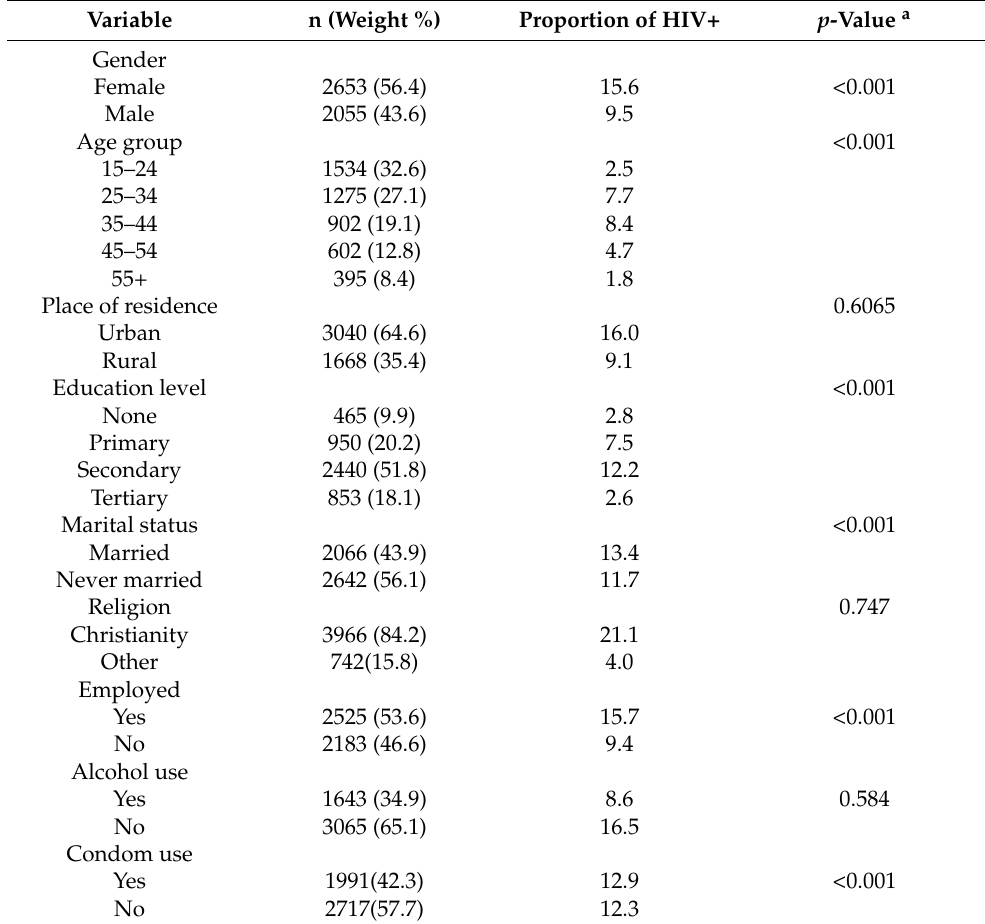
Table 1. Characteristics of study